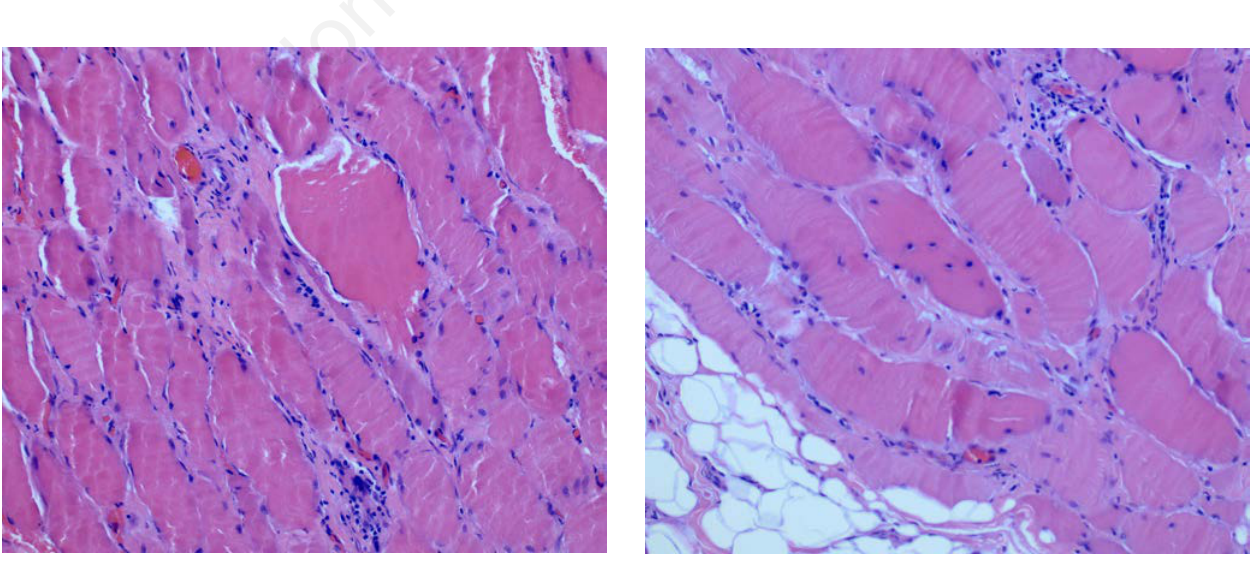
Figure 2. The pictures demonstrate inflammation with some necrotic